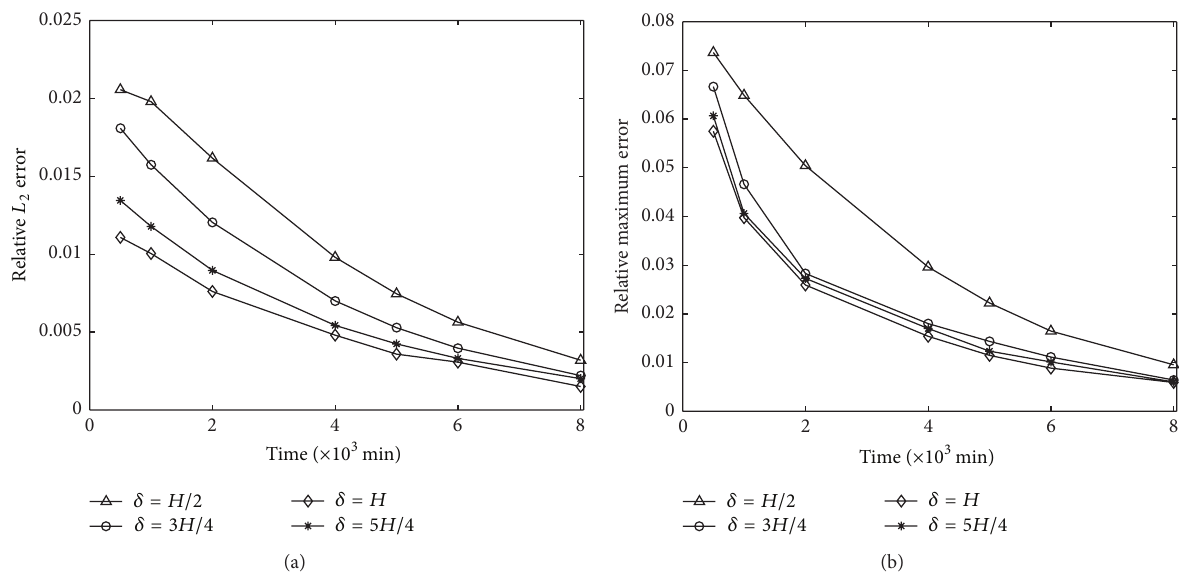
Figure 11: Relative (a) 𝐿 2 and (b) maximum errors between the fine-scale model and the new scheme under different cell sizes for aquifer response to sudden change in reservoir level.